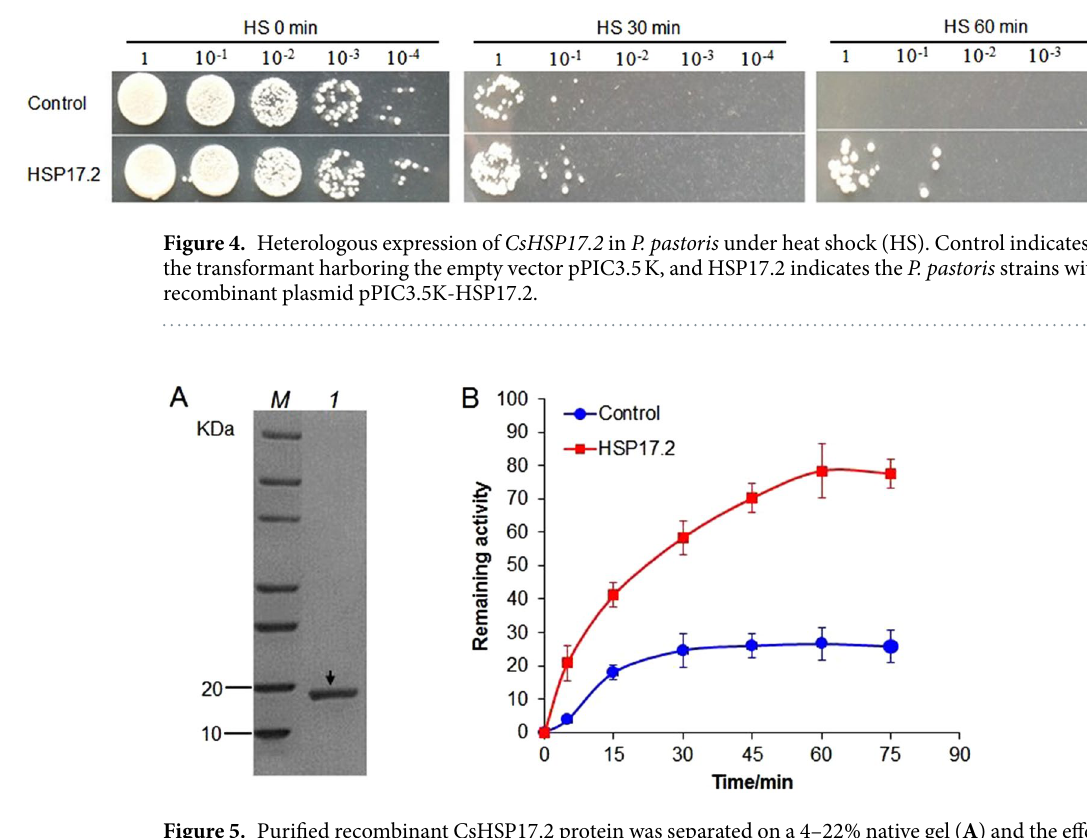
Figure 5. Purified recombinant CsHSP17.2 protein was separated on a 4–22% native gel ( A ) and the effect of CsHSP17.2 protein on the renaturation of chemically denatured citrate synthase (CS) ( B ). M , protein marker; lane 1: recombinant CsHSP17.2 protein. CS (15 μ M) was denatured in 6 M guanidine hydrochloride for 2 h and then placed under refolding conditions containing 150 nM CsHSP17.2 proteins or H 2 O (Control). The remaining activity of CS is presented as the percentage of non-denatured CS activity. Error bars in figures represent standard errors generated from at least three replicate